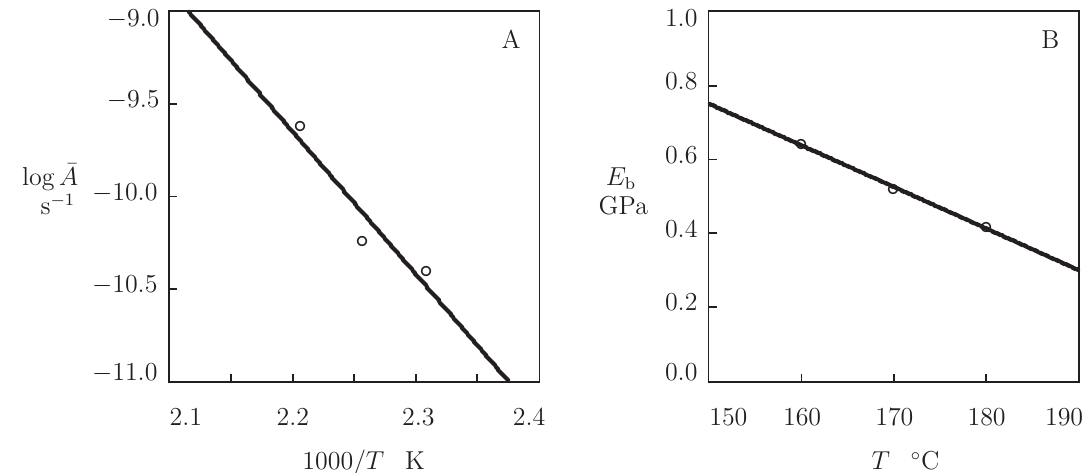
Figure 11. Parameters ¯ A and E b versus temperature T . Circles: treatment of observations in creep tests. Solid lines: ( A )—approximation of the data by Equation (26) with E a = 147.6 kJ/mol. ( B )—approximation of the data by Equation